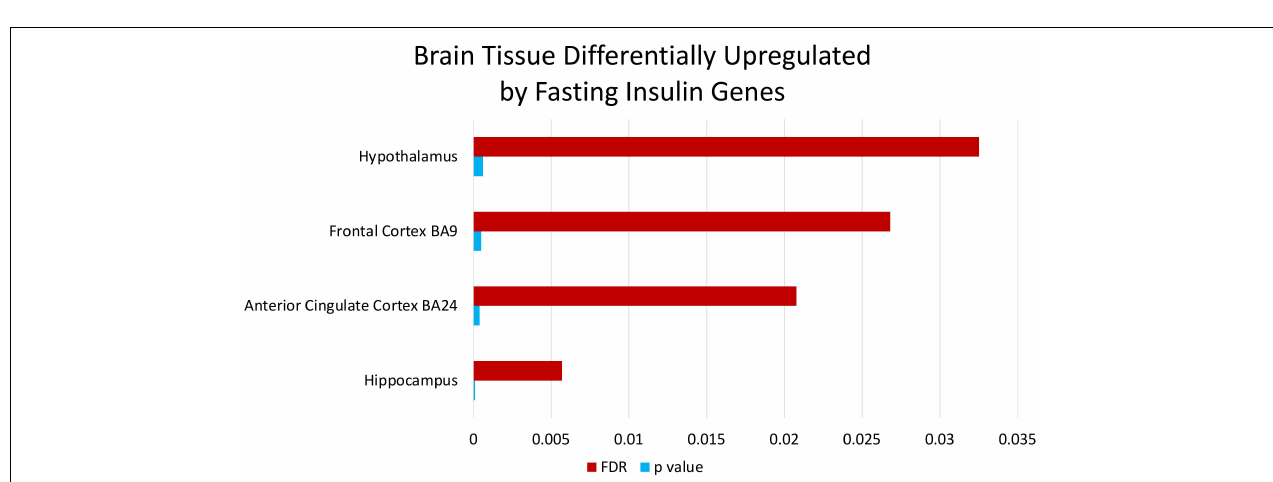
FIGURE 8 | Brain tissue differentially upregulated by fasting insulin genes. Enrichment analysis through FUMA of the genes mapped by the SNPs that compose the fasting insulin rPRS show that these genes are significantly differentially upregulated in brain specific tissues identified in the